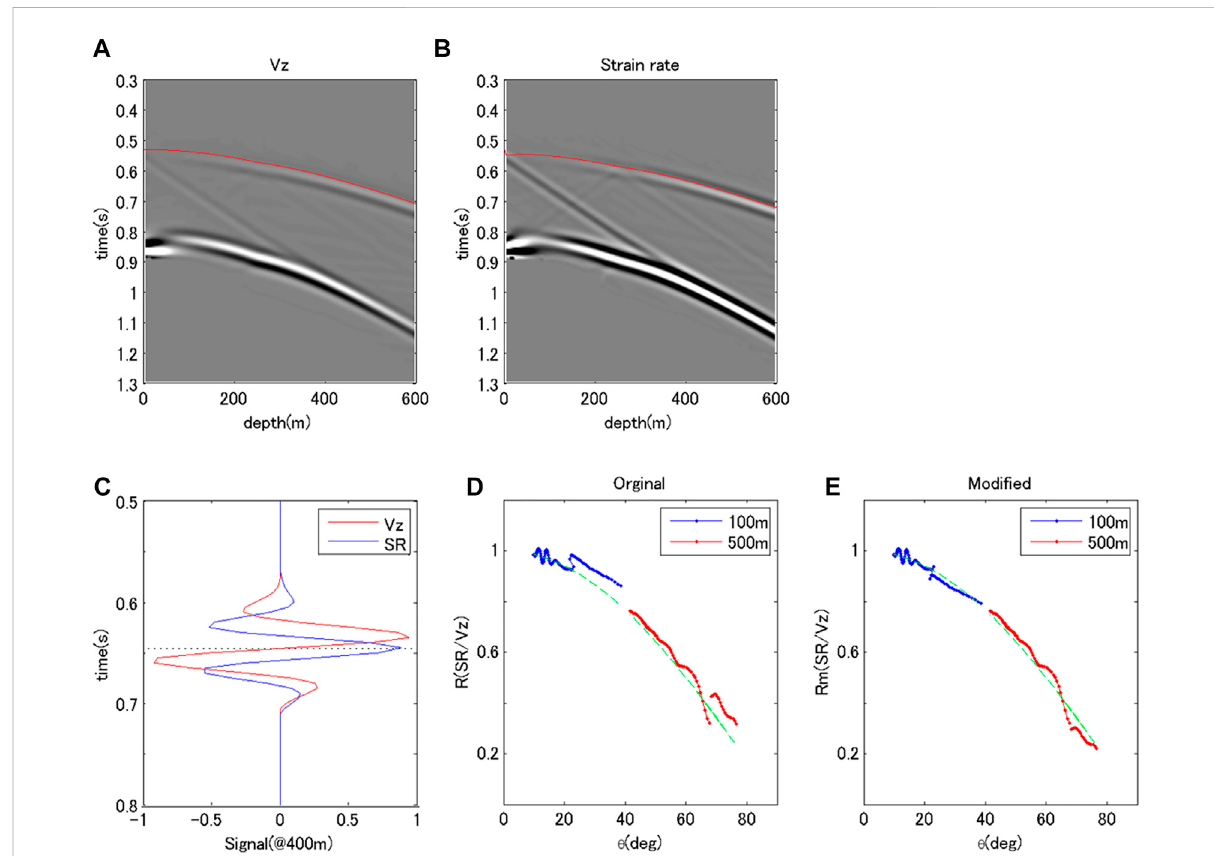
FIGURE 2 Characteristics of the synthetic wave fi eld in a layer mode without a difference in acoustic impedance. (A – D) use the same arrangement as in Figure 1. In wave fi elds shown in (C) , amplitude normalization is the same as in the homogeneous model. (E) shows the amplitude ratio modi fi ed by the effect of apparent velocity. The colors in (E) are the same as in (D)